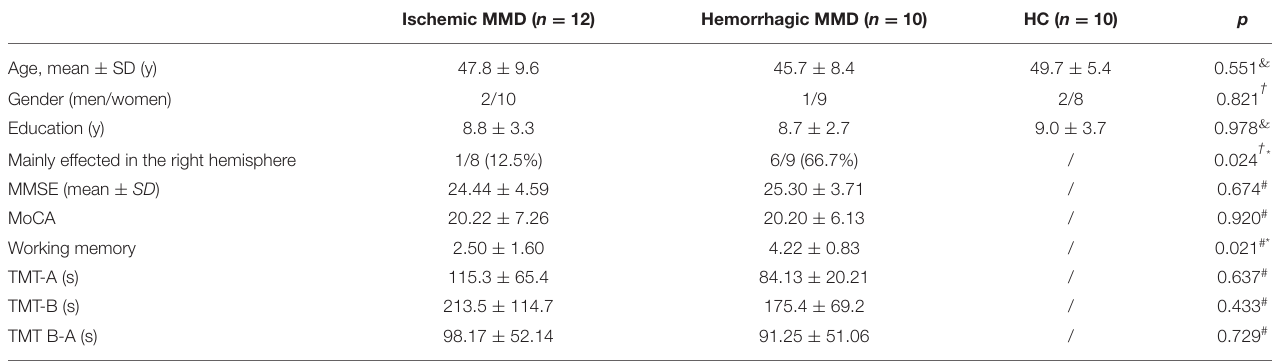
TABLE 2 | Baseline characteristics between two types of MMD and